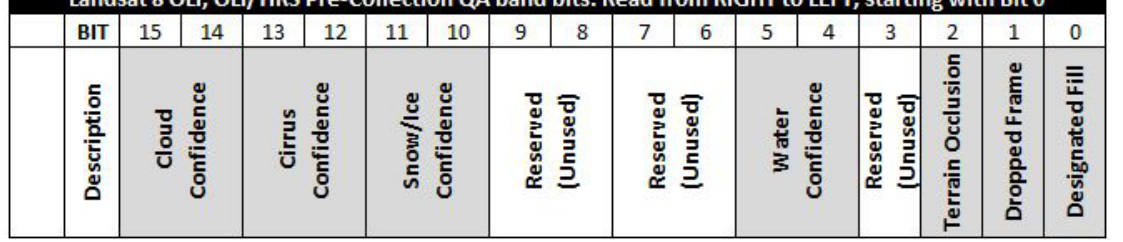
Figure 4. L8 QA band bits and its explanation (Source: https://landsat.usgs.gov/qualityband).